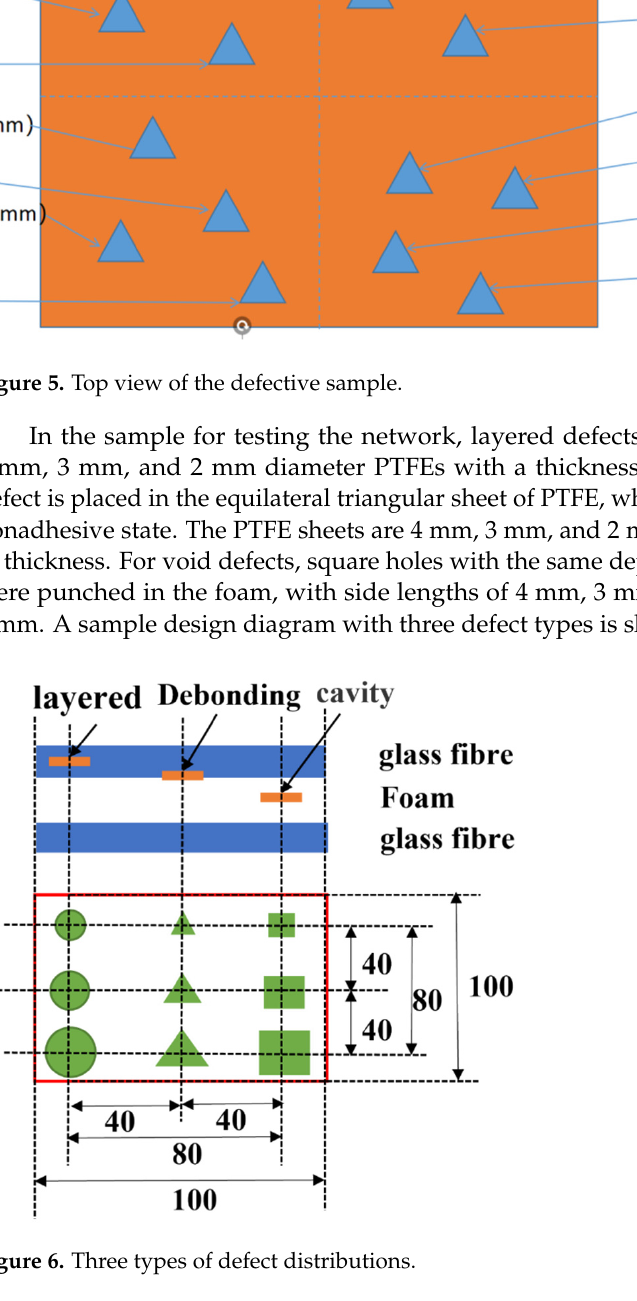
Figure 5. Top view of the defective sample.